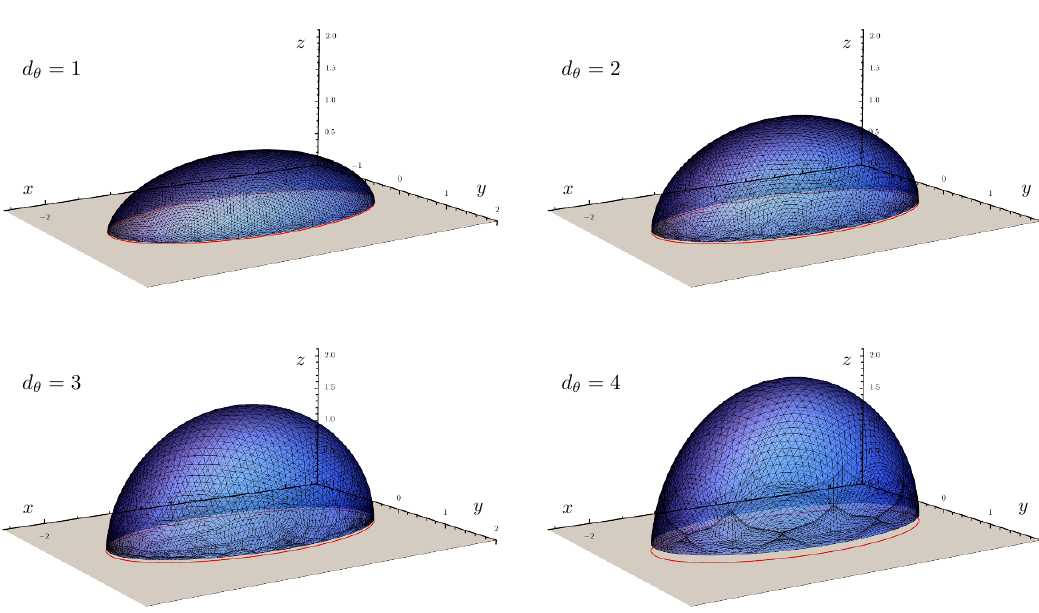
Figure 1 . Minimal area surface obtained with Surface Evolver whose area provides the holographic entanglement entropy of an ellipse A delimited by the red curve. The minimal surface is embedded in a constant time slice of the four dimensional hyperscaling violating Lifshitz spacetime (2.1), whose metric depends on the hyperscaling parameter d (cid:18)